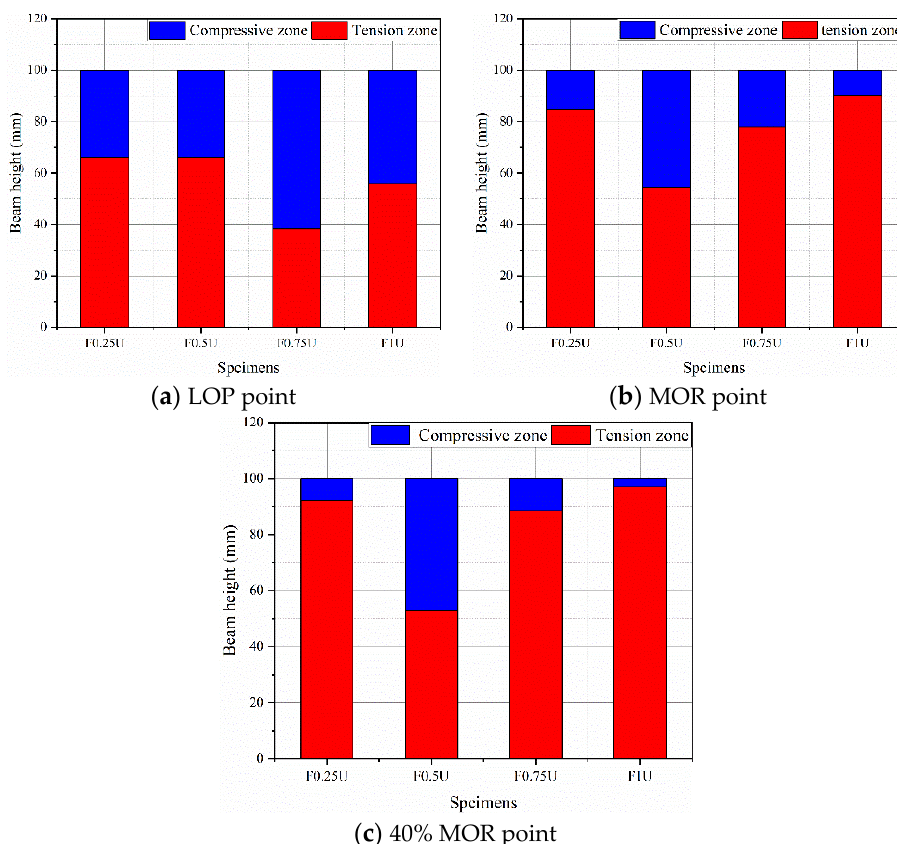
Figure 11. Compressive and tensile zones at LOP point ( a ), MOR point ( b ), and 40%MOR point ( c ). Figure 11b demonstrates the distribution of the longitudinal strain zones of layered FRCM at the MOR point. The tensile zone of F0.25U is 84.5 mm. Although the first cracks in F0.25U started from the top layer, the cracks quickly developed from the bottom due to the small thickness of the bottom layer. Subsequently, the cracks developed rapidly up- ward, leading to the high tensile zone. The crack continues downward from the top layer in F0.5U. The strain transfer reaches the interface (about 50 mm) and then the transfer is restricted. The F0.75U crack develops from the bottom and the bottom fibers transfer the strain upward to the interface (about 75 mm). It is indicated that the influence of the in- terface prevents strain from further development. Strain in the F1U is rapidly transferred upward from the bottom, resulting in a high stretch zone (90.2 mm). The distribution of the longitudinal strain zones of layered FRCM at the 40% MOR point is shown in Figure 11c. At this time, the cracks in F0.25U, F0.75U, and F1U develop